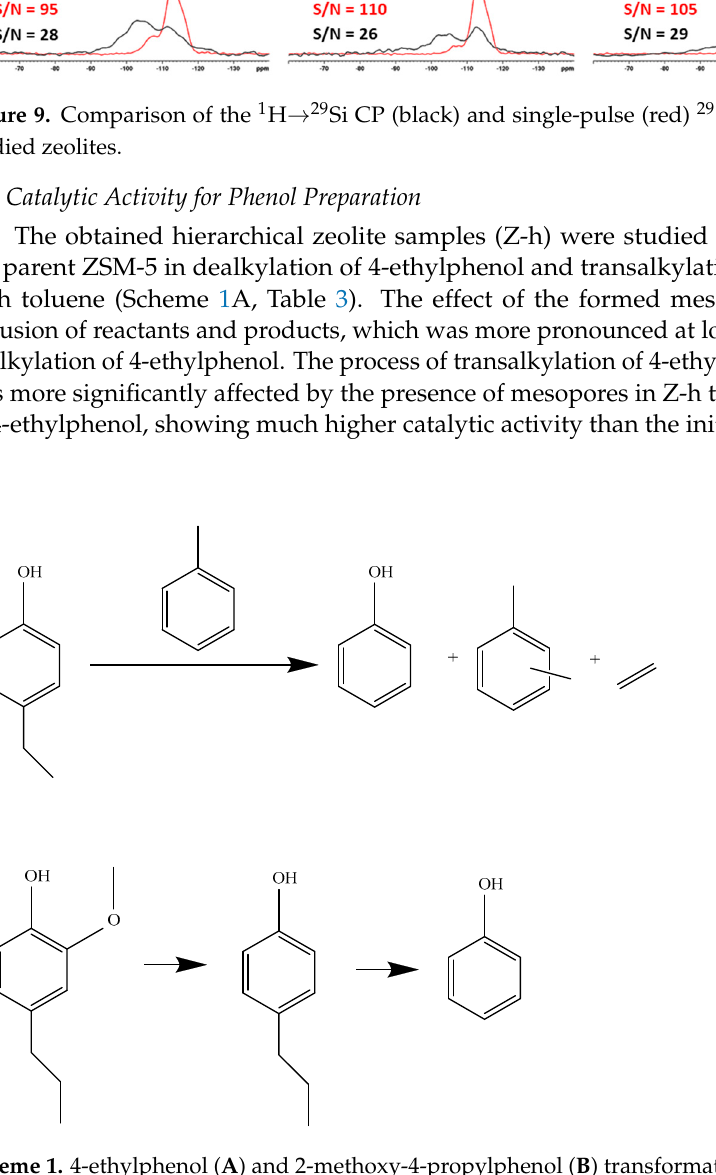
Table 3. Catalytic activity of the initial and hierarchical ZSM-5 zeolite in dealkylation of 4-ethylphenol and transalkylation of 4-ethylphenol with